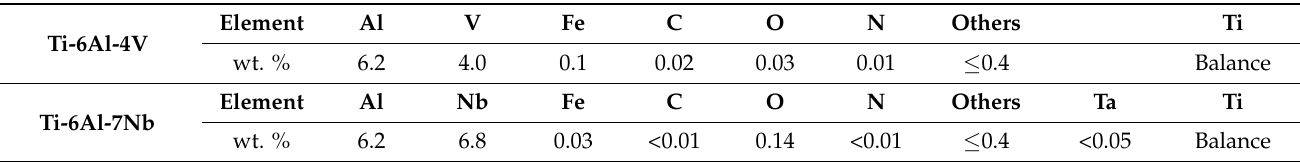
Table 1. Chemical composition of titanium